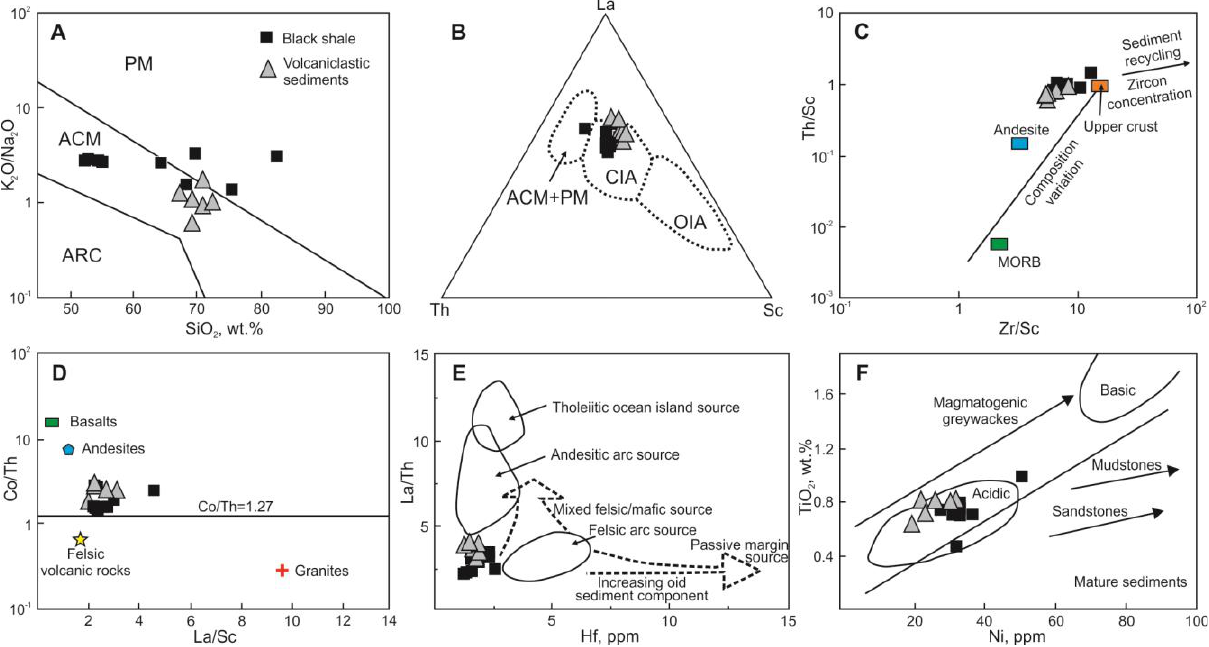
Figure 9. Source, provenance and tectonic interpretation diagrams for sedimentary rocks from the Priorat DOQ region. ( A ) SiO 2 (wt.%) vs. K 2 O/Na 2 O; fields of oceanic island arc (ARC), active continental margin (ACM) and passive margin (PM) sediments are from [50]. ( B ) Th – La – Sc graph; fields for oceanic island arc (OIA), continental island arc (CIA), active continental margin (ACM) and passive margin (PM) sediments are from [51]. ( C ) Th/Sc vs. Zr/Sc graph; average compositions of mid-ocean ridge basalt (MORB), andesite, upper continental crust and chemical trends are from [52]. ( D ) Co/Th vs. La/Sc; average compositions of various source rocks for clastic sediments are from [53]. ( E ) La/Th vs. Hf (ppm); compositional fields and principal chemical trends are from [54]. ( F ) Ni (ppm) vs. TiO 2 (wt.%); sediment sources and main compositional trends are from [55].